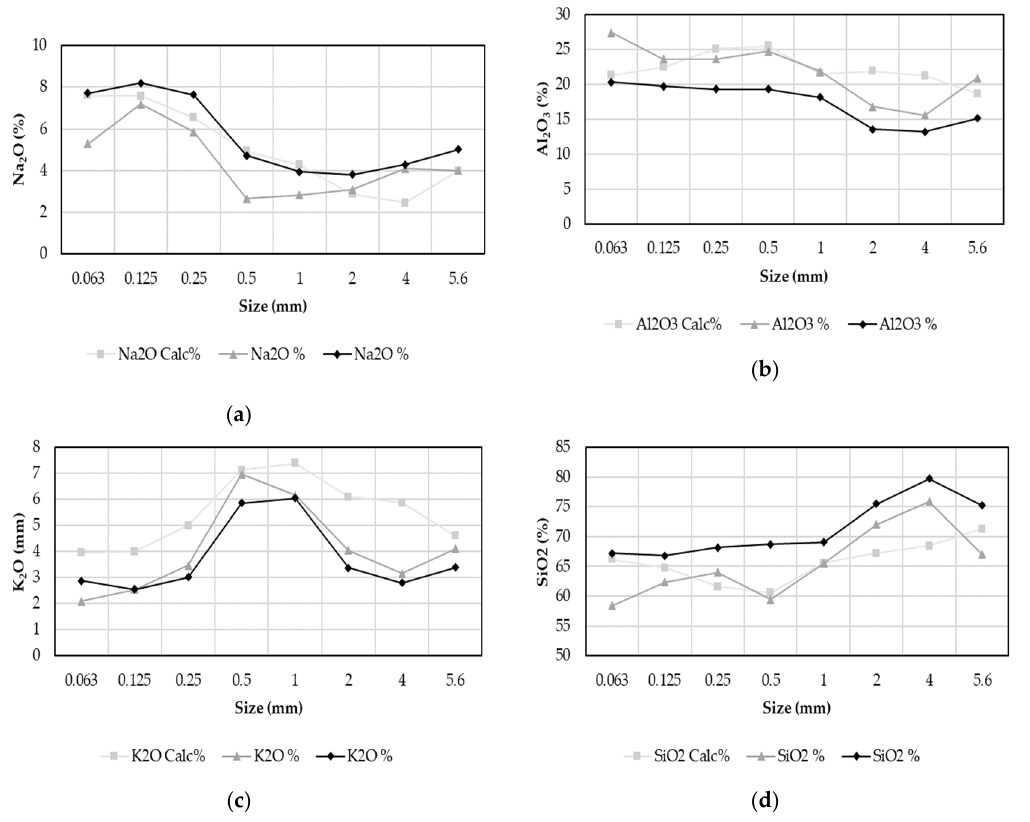
Figure 8. Chemical composition for ( a ) sodium oxide, ( b ) aluminum oxide, ( c ) potassium oxide and ( d ) silica oxide, recalculated from mineral modal abundance determined by XRD (K 2 O Calc%) compared to chemical analysis of sample 1, show that XRD and bulk chemical analysis produce reasonably consistent results.